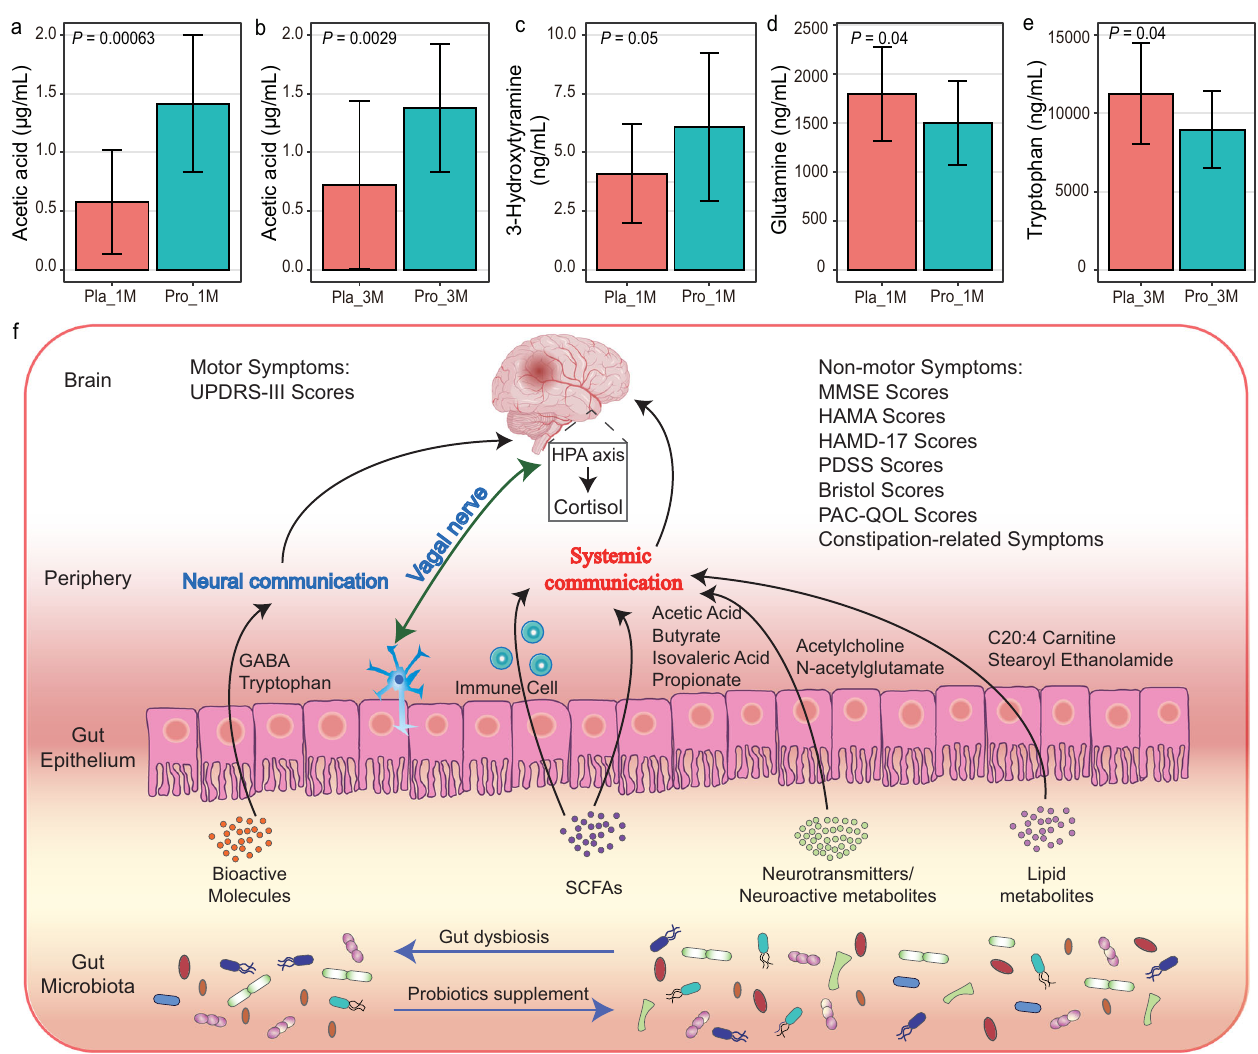
Fig. 5 Differences in serum short-chain fatty acids (SCFAs) and neuroactive compounds between Probio-M8 (Pro) and placebo (pla) groups and proposed model of probiotic-driven pathways modulating the gut-brain-axis in patients with Parkinson ’ s disease. a – e Signi fi cant differences in serum SCFAs and neuroactive compounds between the probiotic and placebo groups at 1 month (1 M) and 3 months (3 M), error bars represented SD; P < 0.05 was considered statistically signi fi cant. f Schematic diagram illustrating key probiotic-driven pathways that modulated the gut-brain-axis and host response. UPDRS-III, MMSE, HAMA, HAMD-17, PDSS, and PAC-QOL represent Uni fi ed PD Rating Scale-III, Mini-mental State Examination, Hamilton Anxiety Scale, Hamilton Depression Scale-17, Parkinson ’ s Disease Sleep Scale, Patient-Assessment of Constipation Quality of Life, respectively. GABA and SCFAs represent gamma-aminobutyric acid and short-chain fatty